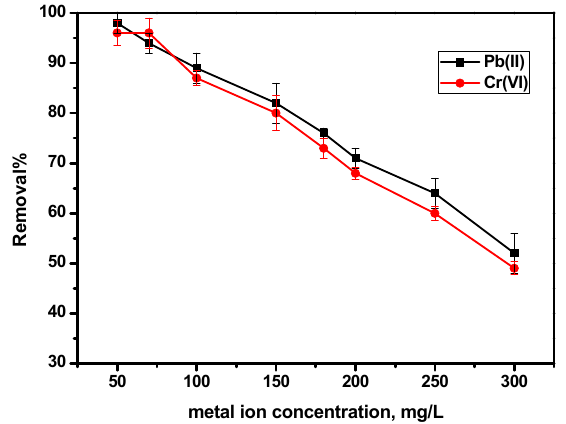
Figure 3. E ff ect of metal ion concentrations on the adsorption e ffi ciency. Figure 3. Effect of metal ion concentrations on the adsorption efficiency.